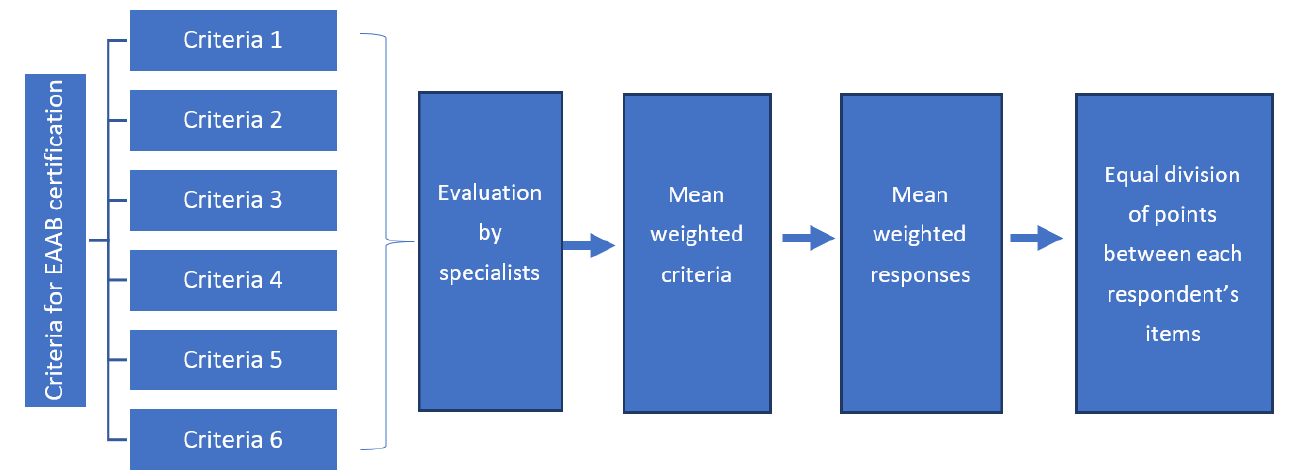
Figure 1. Flow of steps to calculate the weighted values of criteria and respondents to evaluate the degree of implementation of the EAAB in the Federal District, Brasília,